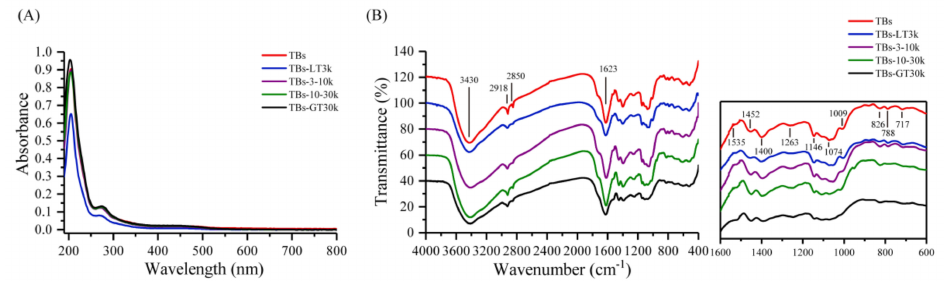
Figure 1. Ultraviolet–visible spectra ( A ) and Flourier transformation infrared spectra ( B ) of theabrownins (TBs) and fractionated theabrownin samples with di ff erent molecular weights. TBs-LT3k, TBs-3-10k, TBs-10-30k, and TBs-GT30k represented the theabrownin samples with molecular weights: < 3 kDa, 3–10 kDa, 10–30 kDa, and > 30 kDa,